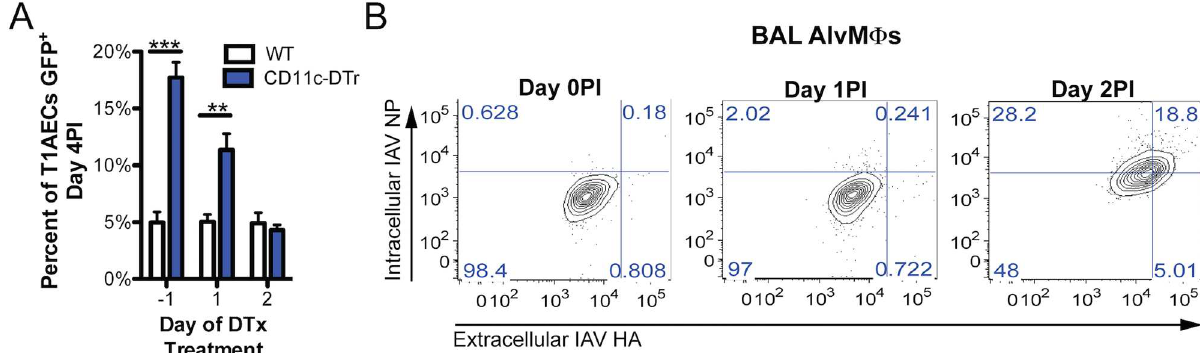
Fig 4. AlvM Φ sfunction early in infection to confer resistance of type 1 alveolar epithelial cell to IAV infection. a) CD11c-DTr+ and WT control littermates were given 40ng of DTx i.n. at the indicatedtime points pre or post infection with NS1-GFP A/PR/8. The percentage of infected T1AECs was quantified at day 4PI. b) WT mice were infected i.n. with a 0.1LD50of A/PR/8 and BAL AlvM Φ swere isolated and stained for cell surface IAV HA antigenand intracellularIAV NP antigenat the indicatedtime points. Data were pooledfrom a minimum of 3 experiments with a total of 4–6 mice per genotypeat each indicatetime point. Flow plots are representative from 5 mice. Error bars are standard error mean. For statistical analysis2-way ANOVA test were used. * indicatesP < .05, ** for P < .001 and *** for P <